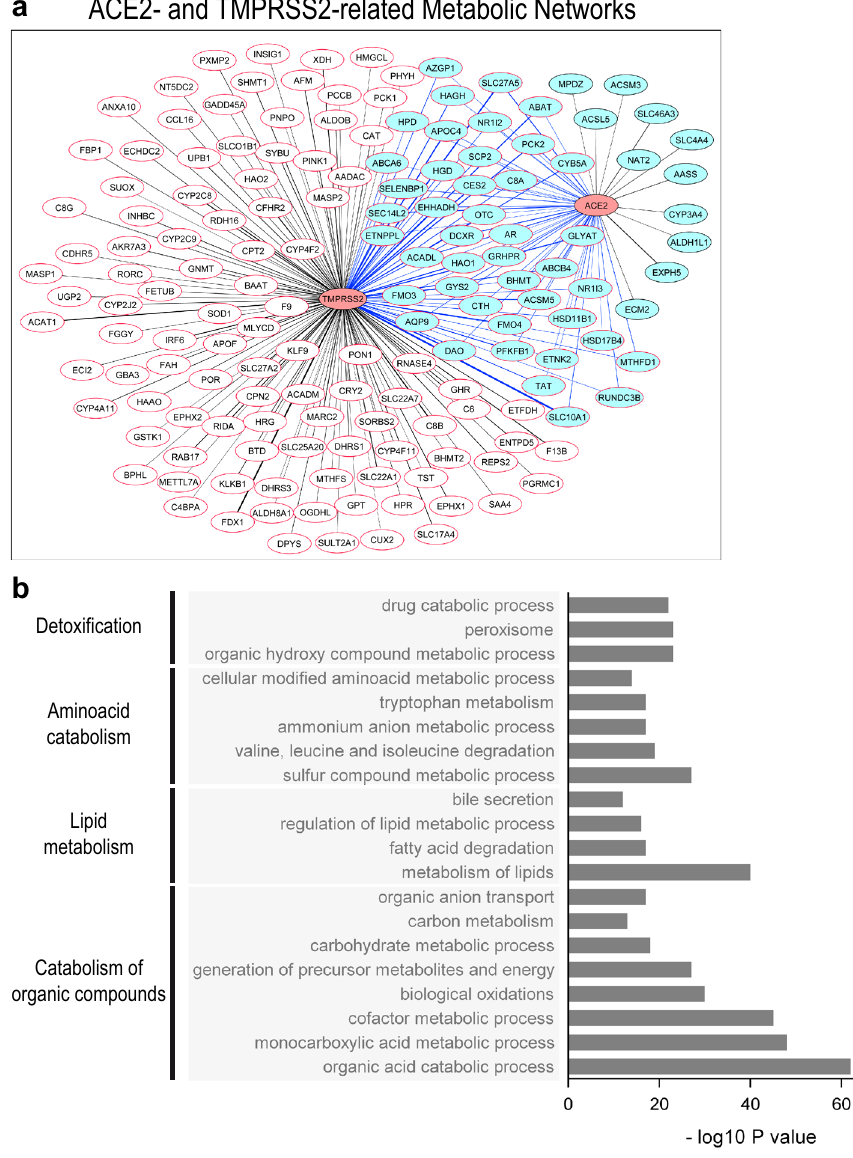
Figure 4. ( a ) Connections between the ACE2 and the TMPRSS2 expression networks in the Désert’s meta- dataset 26 , in non-proliferative-moderately-to-well-differentiated, periportal-type and perivenous-type HCCs 24 . The co-expression network was identified by Weighted Gene Correlation Network Analysis and the WGCNA 36 R package, followed by visualization with Cytoscape 49 . Genes co-expressed with ACE2, light-blue nodes with black borders and black links ; genes co-expressed with TMPRSS2, white nodes with red borders and black links ; genes co-expressed with both ACE2 and TMPRSS2, light-blue nodes with red borders and blue links. Link thickness is proportional to the correlation coefficient between a given node and ACE2 or TMPRSS2. ( b ) Functional analysis and gene ontology enrichment of the gene co-expression network shown in b are visualized with Express Analysis from Metascape 50 . Gene ontology (GO) terms, families and P values are